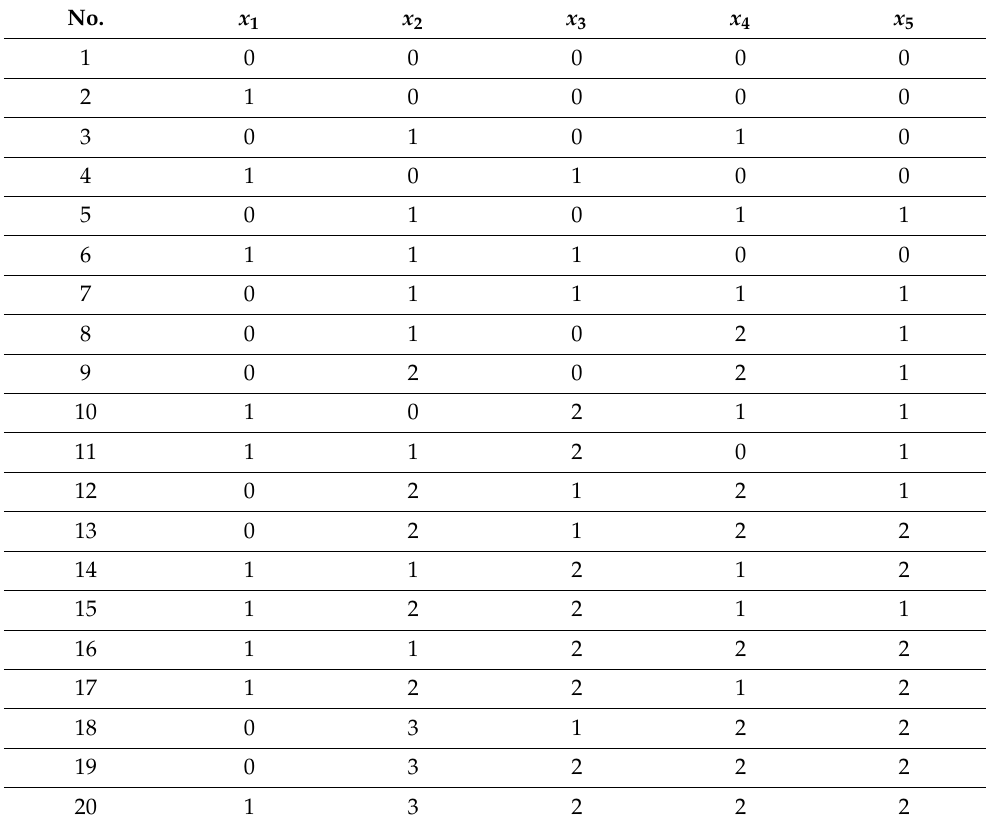
Table 2. Optimal decisions as a learning